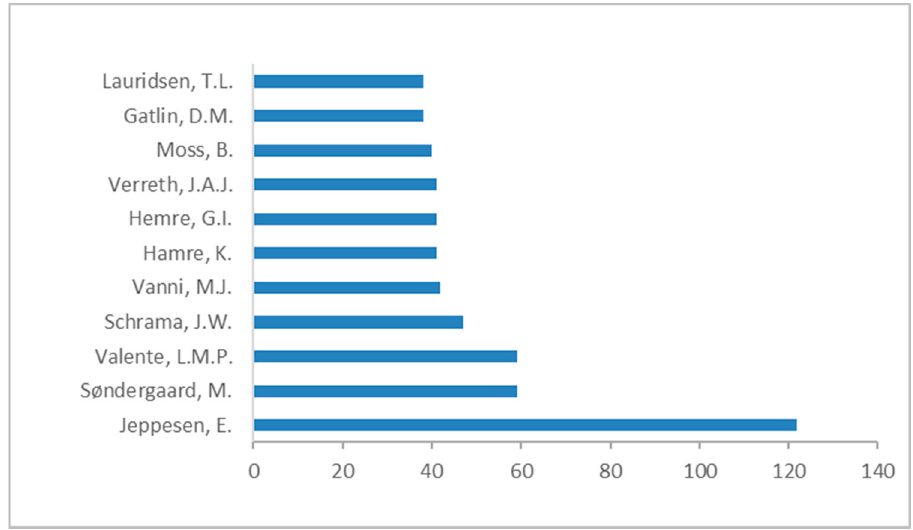
Figure 4. The most productive authors. (Based on data from Scopus).